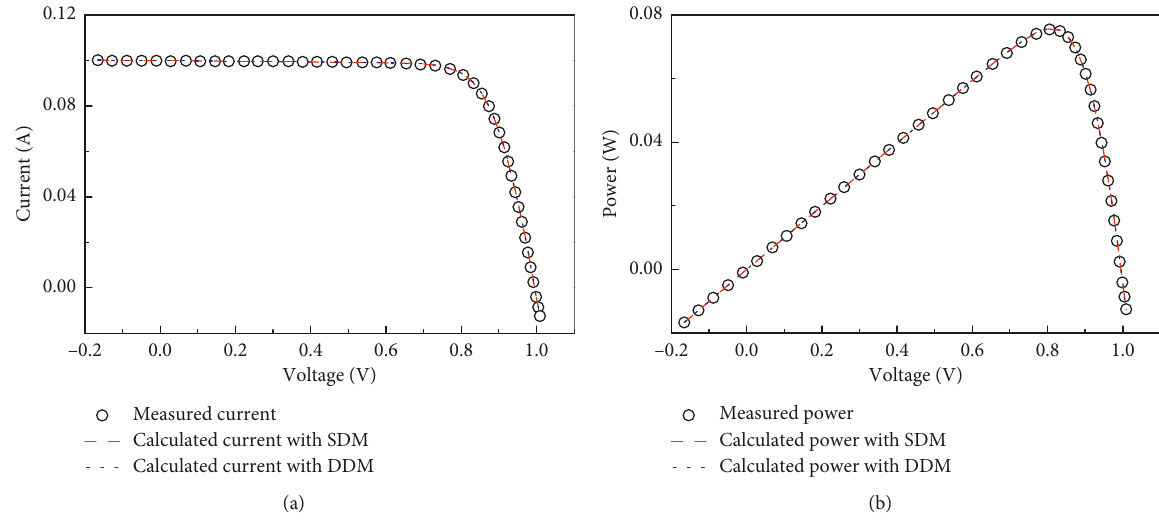
Figure 8: Comparison between the measured and calculated data achieved by SDO for the PVM 752 GaAs thin film cell. (a) I-V characteristic; (b) P-V